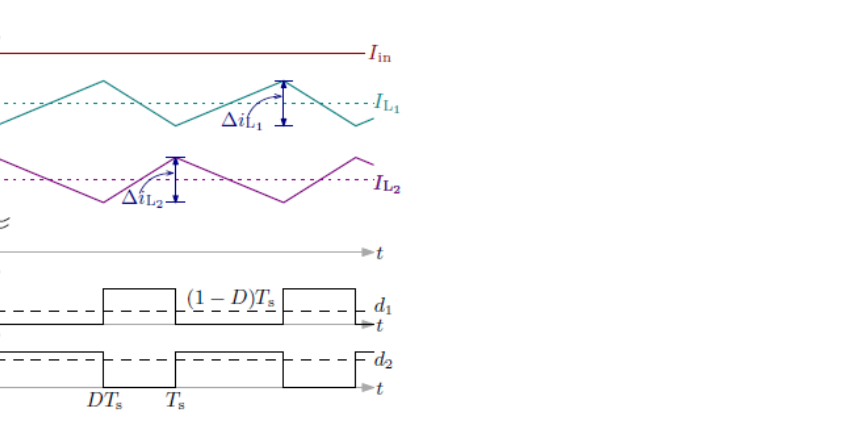
j ( t ): complementary PWM